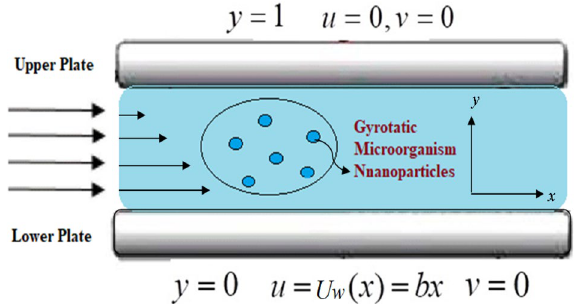
Figure 1. Fluid flow between two parallel